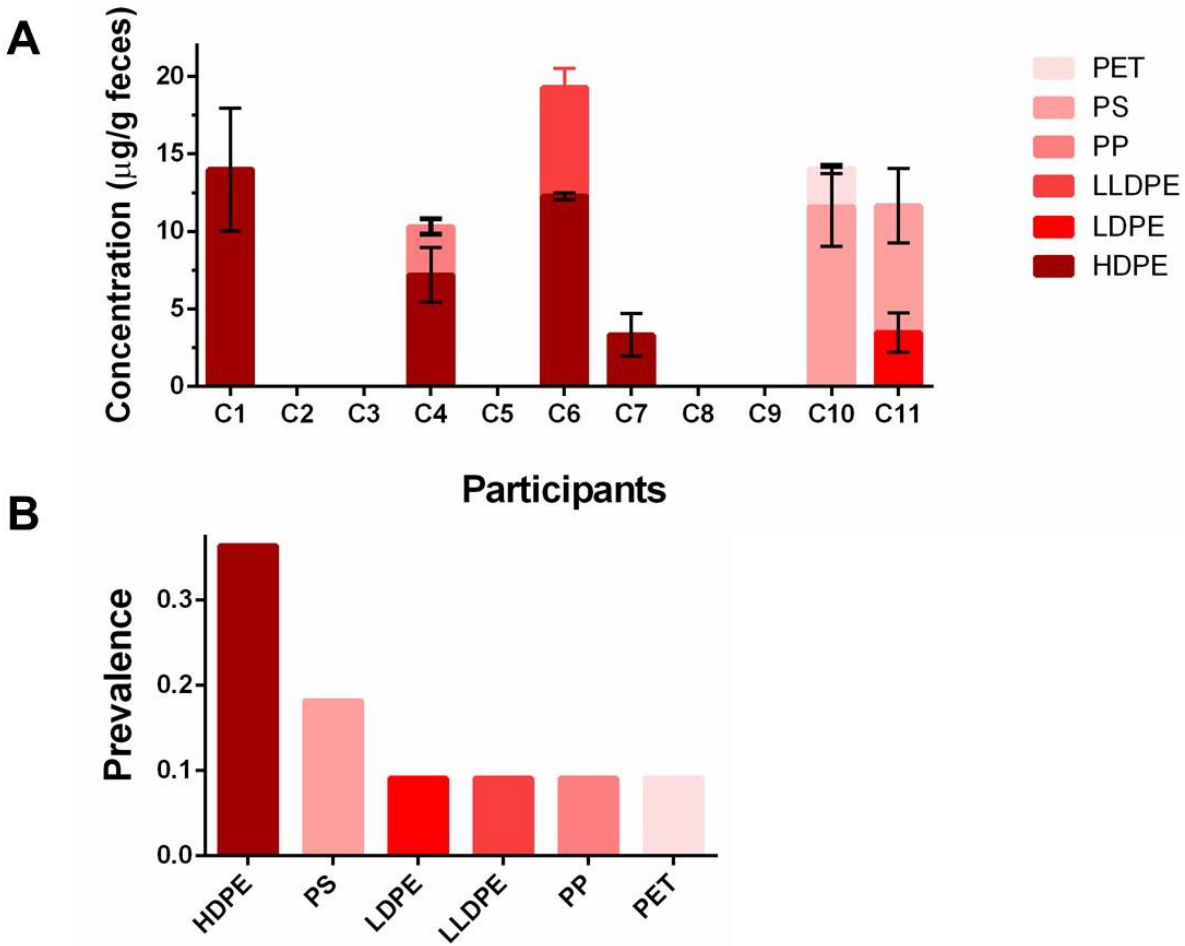
Figure 1. Concentration and prevalence of microplastics in stool samples collected from coastal populations of Kenjeran, Surabaya, Indonesia. ( A ) Various types of microplastics were detected in 6 out of 11 stool samples; ( B ) prevalence of different microplastic types in the studied population.